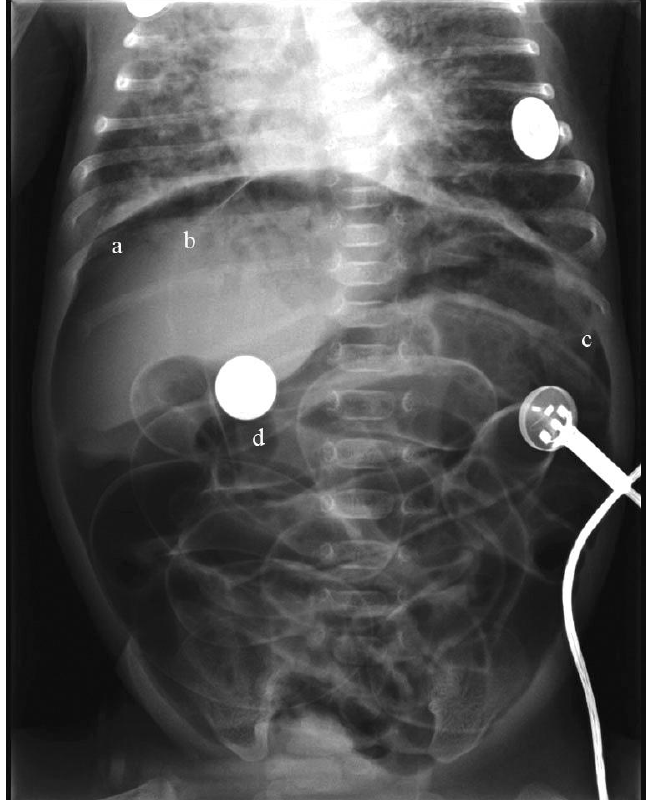
FIGURE 1. A plain abdominal film showing air in the bowel walls and a large pneumoperitoneum (subdiaphragmatic free air, perihepatic free air, double wall sign [a and b], triangle sign [c], and falciform ligament